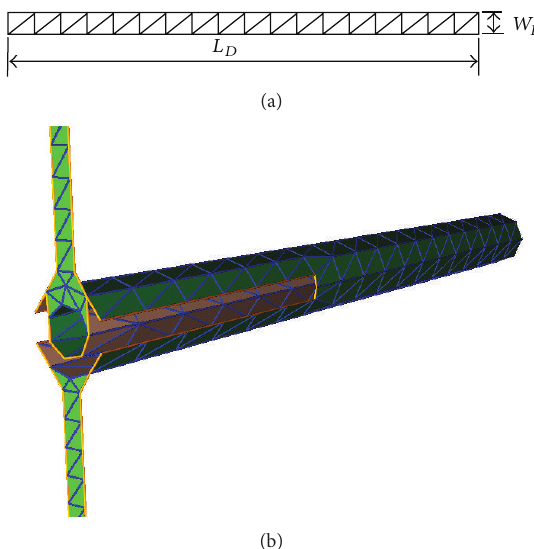
= 4 mm, 𝐿 = 2 in 1 out = 3.82 cm, 𝐿 = 2 in 𝑡